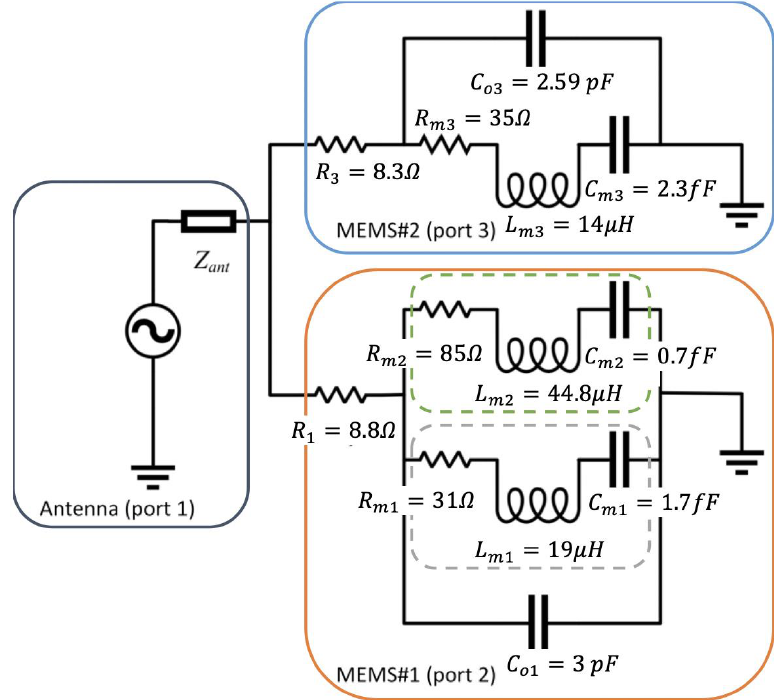
Figure 2. The equivalent circuit model of the sensor in receive mode. The model of the sensor (MEMS#1) is outlined in orange with the mechanical branches corresponding to each of the two modes outlined in green and gray. The model of the reference device (MEMS#2) is outlined in light blue. The antenna is modeled as a voltage source in series with a complex load is outlined in dark blue.